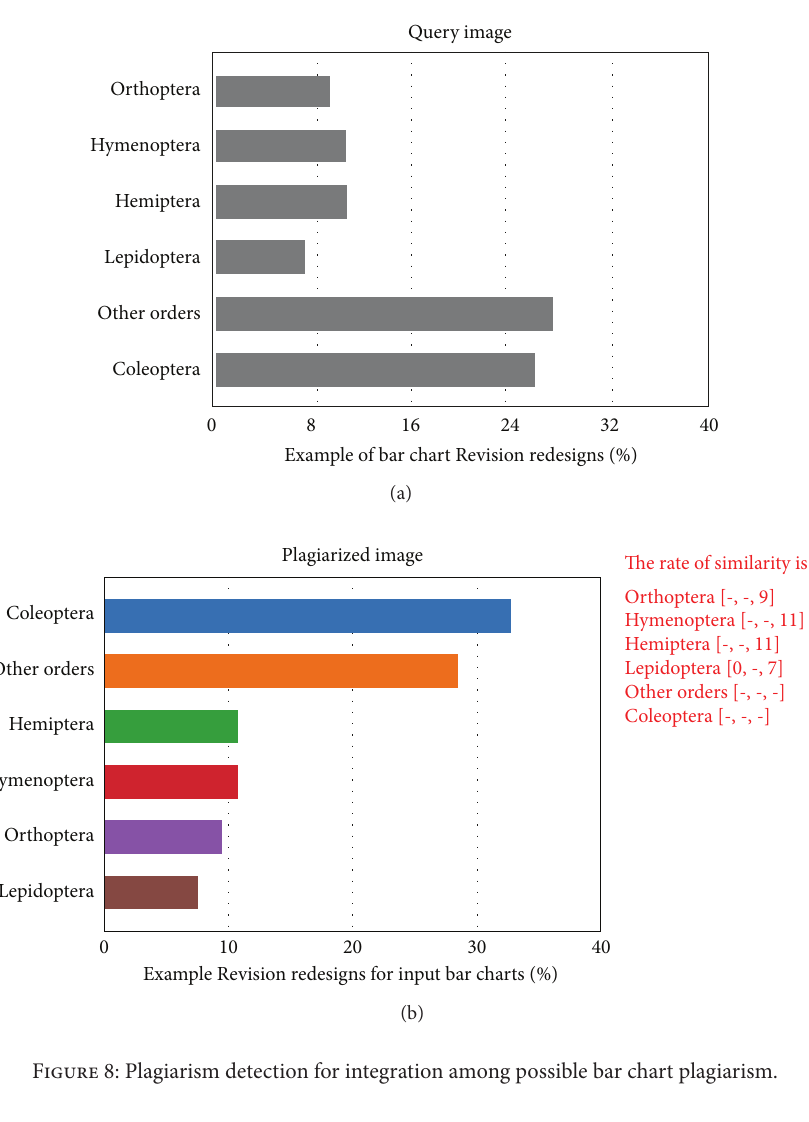
Figure 8: Plagiarism detection for integration among possible bar chart plagiarism.